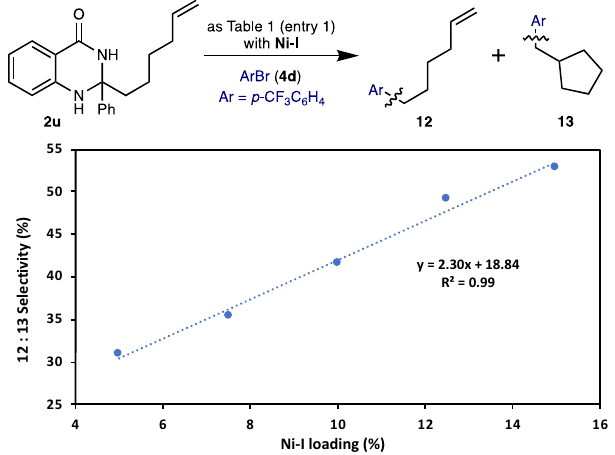
Fig. 6 Radical cyclization as a function of catalyst loading. 2 u (0.12 mmol), 4d (0.10 mmol), Ni(OAc) 2 ·4H 2 O (10 mol%), L4 (15 mol %), 4-CzIPN (2 mol%), NaBr (1.2 eq.), Na 2 CO 3 (1.0 eq.) in NMP (0.10 M) at 40 °C, for 24 h.